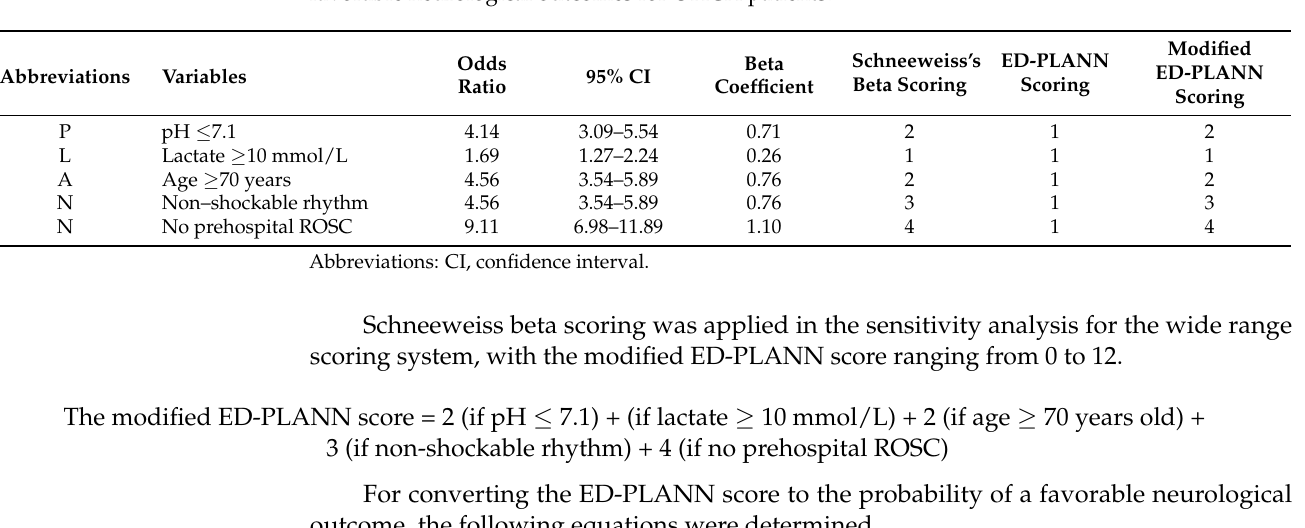
Table 2. ED-PLANN score and modified ED-PLANN score: simple risk stratification scores predicting favorable neurological outcomes for OHCA